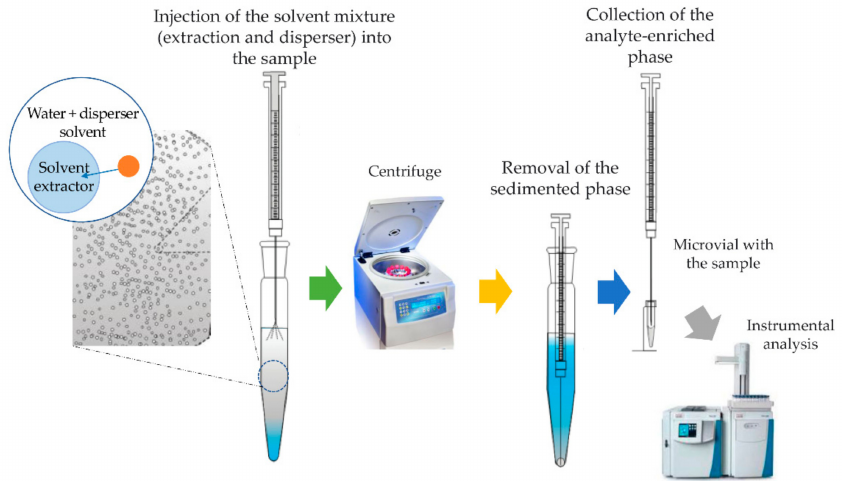
Figure 2. A simplified schematic diagram demonstrating the DLLME principle (adapted from Yazdi and Amiri